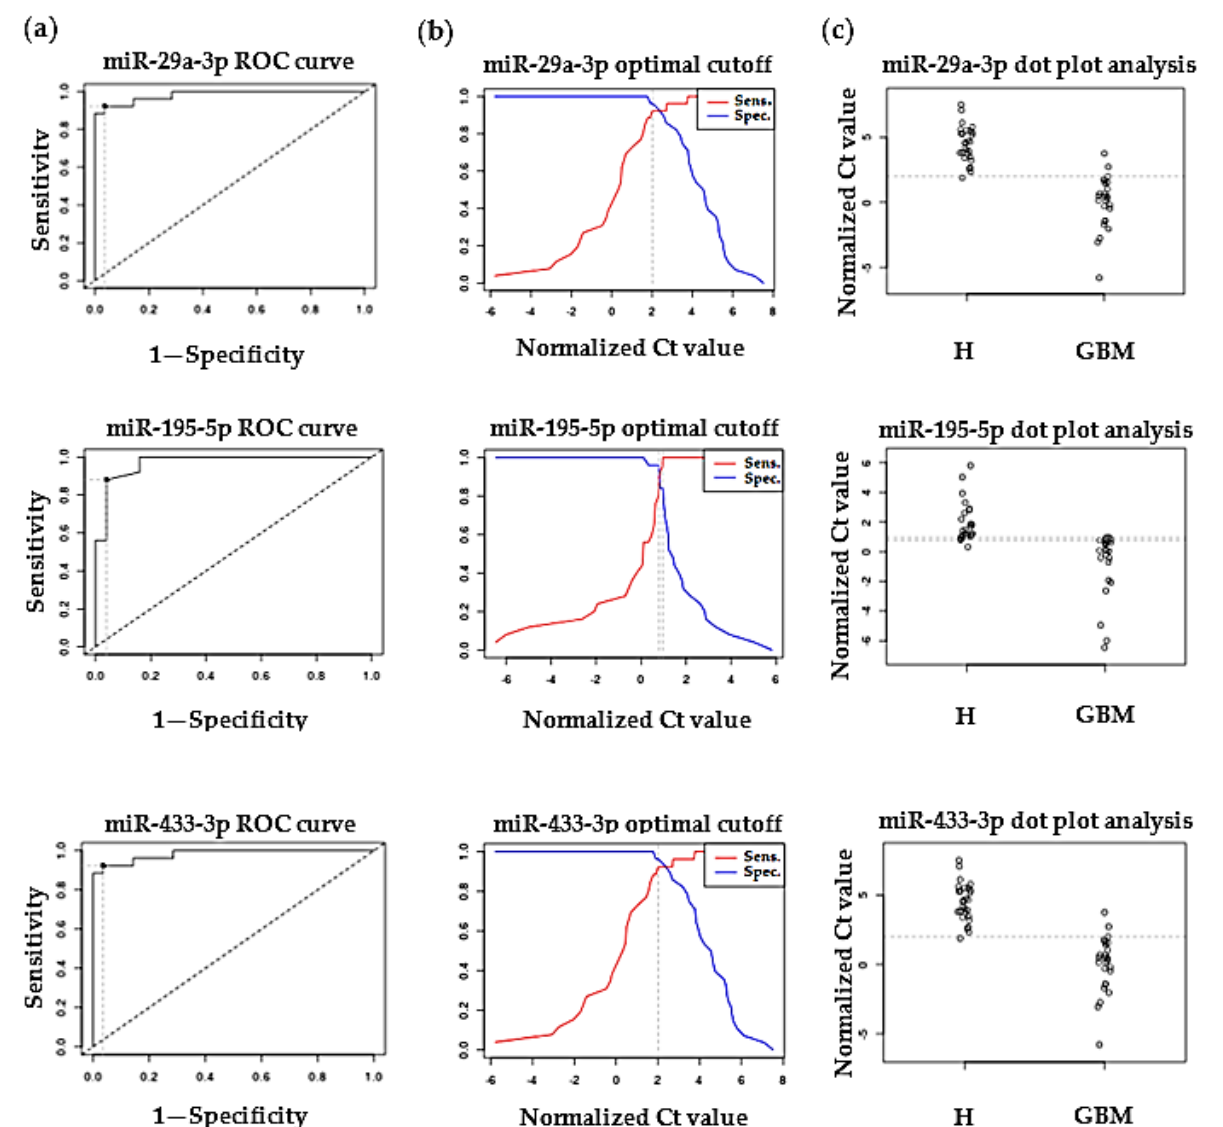
Figure 2. ( a ) ROC (receiver operating characteristics) curves with AUC (area under the curve) were made to check and visualize the performance of miR-29a-3p, miR-195-5p, and miR-433-3p, randomly selected for the validation of the NanoString measurement via qRT-PCR. ( b ) Estimated optimal cut-point values of miR-29a-3p (normalized Ct value: 2), miR-195-5p (normalized Ct value: 0.97), and miR-433-3p (normalized Ct value: 2). ( c ) Dot plot analysis of miR-29a-3p, miR-195-5p, and miR-433-3p for GBM patients (GBM) and healthy controls (H).